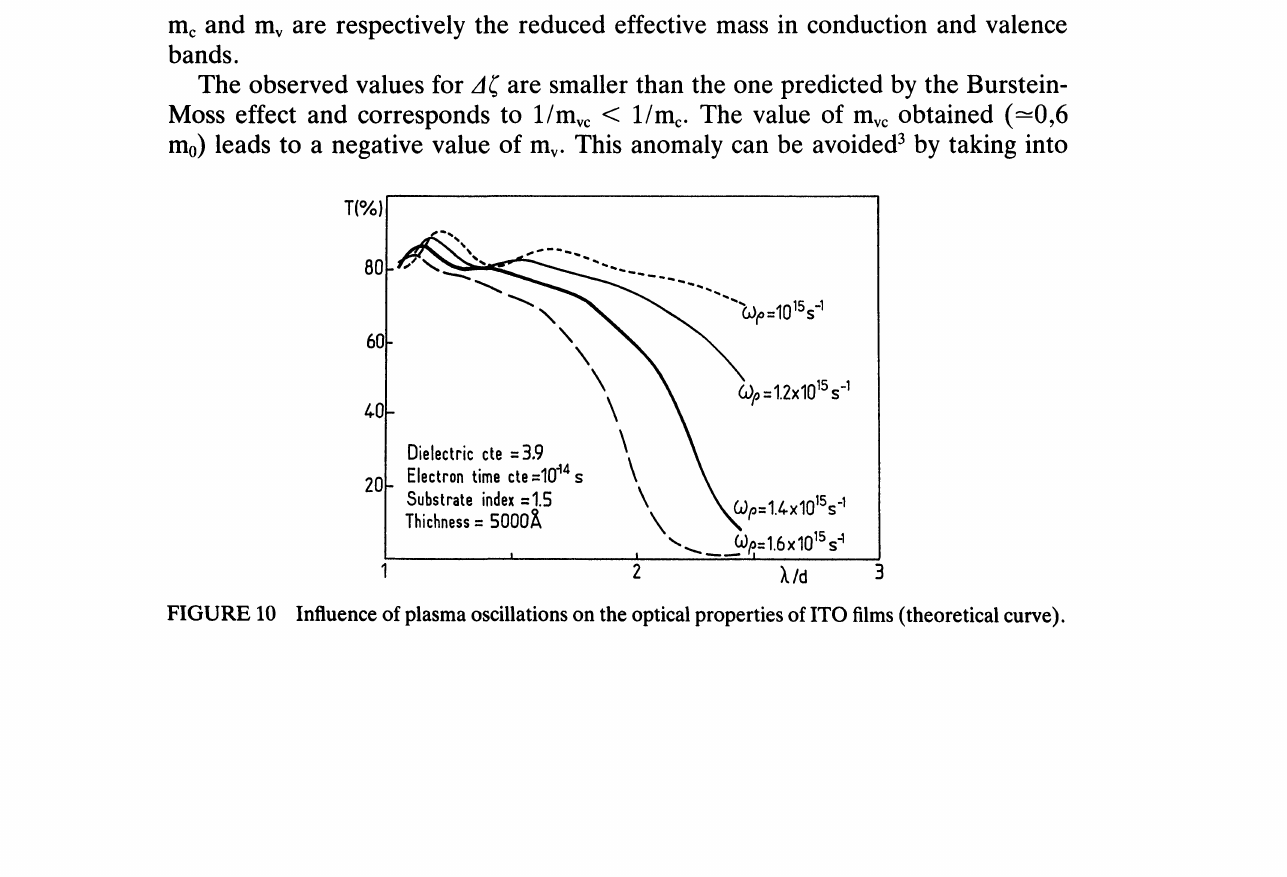
FIGURE 9 Wavelength dependence of the optical constants n’ and k.